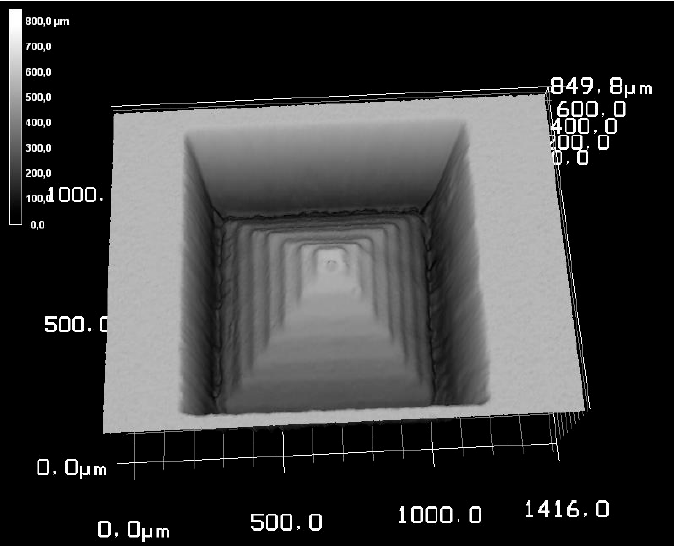
Figure 7. Laser scanning microscope image of a fiber laser micro machined submerged pyramid in